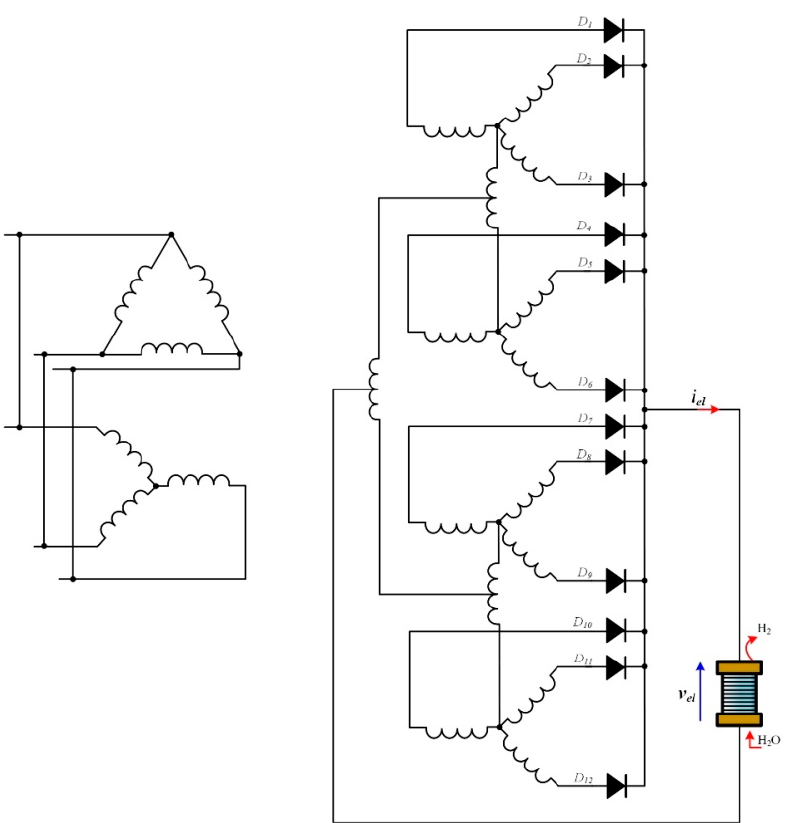
Figure 7. Single-way 12-pulse diode double-star rectifier with interface inter-phase transformers.